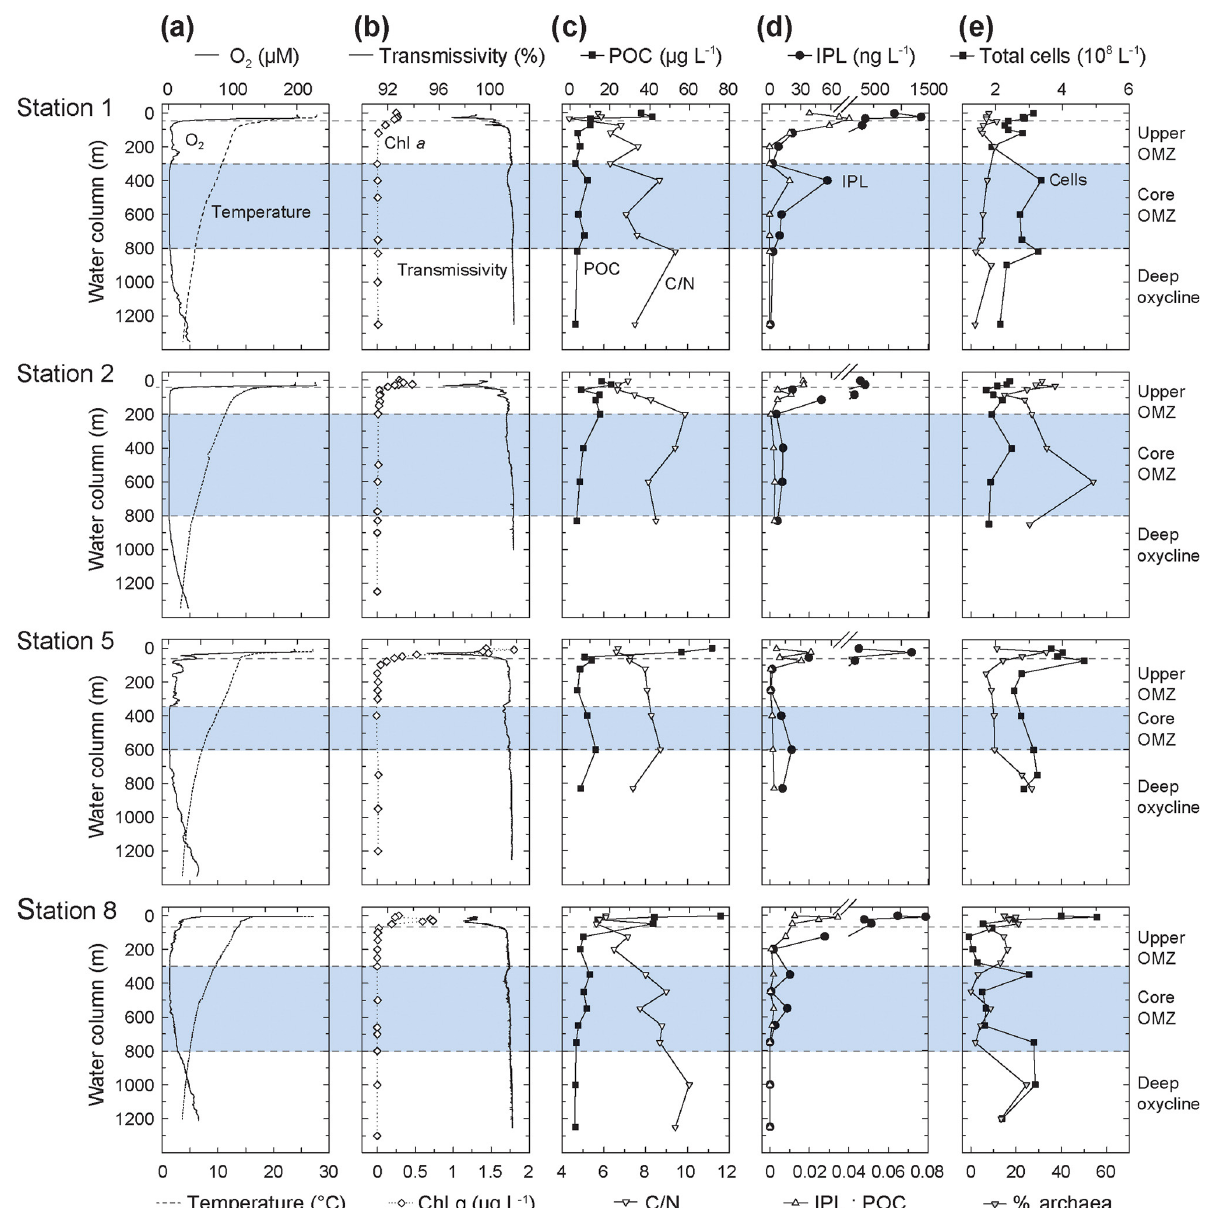
Figure 2. Depth profiles of (a) oxygen and temperature, (b) Chlorophyll α and transmissivity, (c) particulate organic matter (POC) and C : N, (d) ratio of intact polar lipid (IPL) to POC and IPL concentration, and (e) absolute cell abundance and relative proportions of archaeal cells (data from Podlaska et al., 2012). C : N (SPM) is the total carbon over total nitrogen of the solid phase collected by water filtration. Note that C : N, POC and IPL/POC are only analyzed for the < 53µm particle fraction. Also depicted are the different geochemical zones in the water